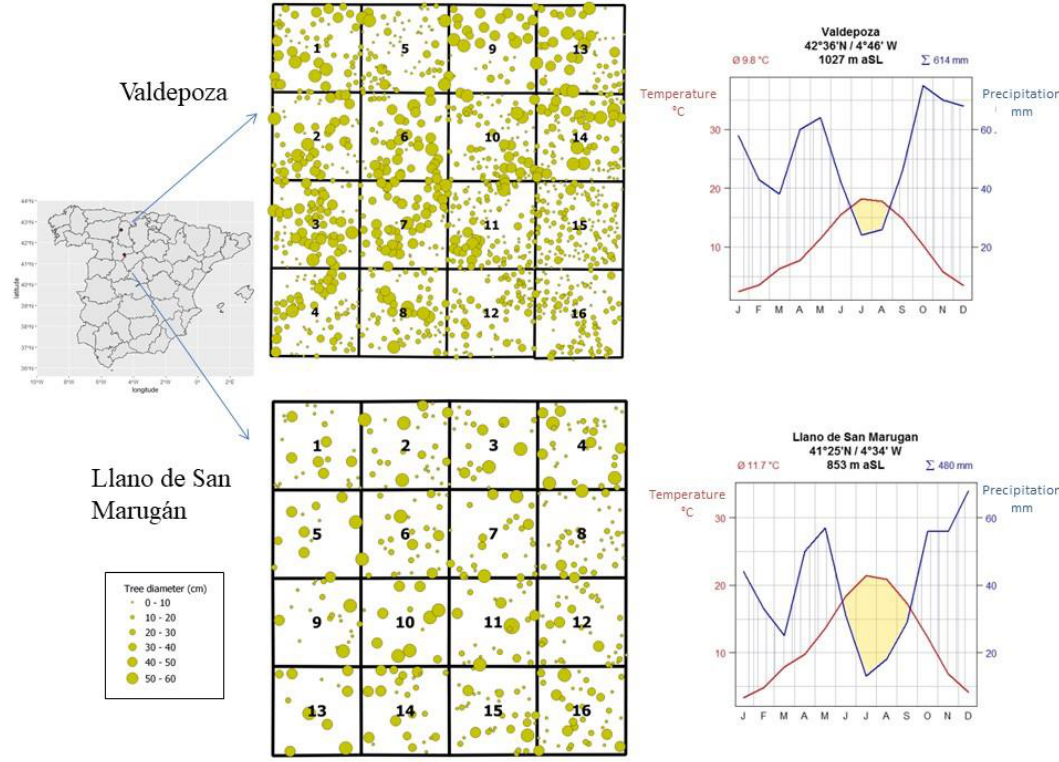
Figure 1. Study sites in the Castile and Leon region (Spain) and experimental plot design and tree location for the two experimental sites (size of the circle is proportional to tree diameter (from 0 to 60 every 10 cm). Climate diagram displays monthly average temperature in degrees Celsius ( ◦ C) (red line) and precipitation in millimeters (mm) (blue line) by the standards of Walter and Lieth climodiagram. Observations from 1981–2010 from AEMET weather stations and processed by ITACYL.